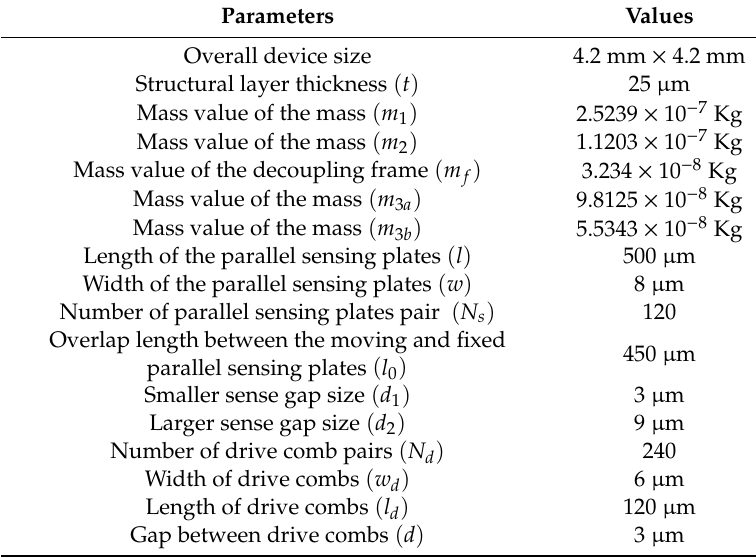
Table 2. Design parameters of the proposed multi-DoF MEMS